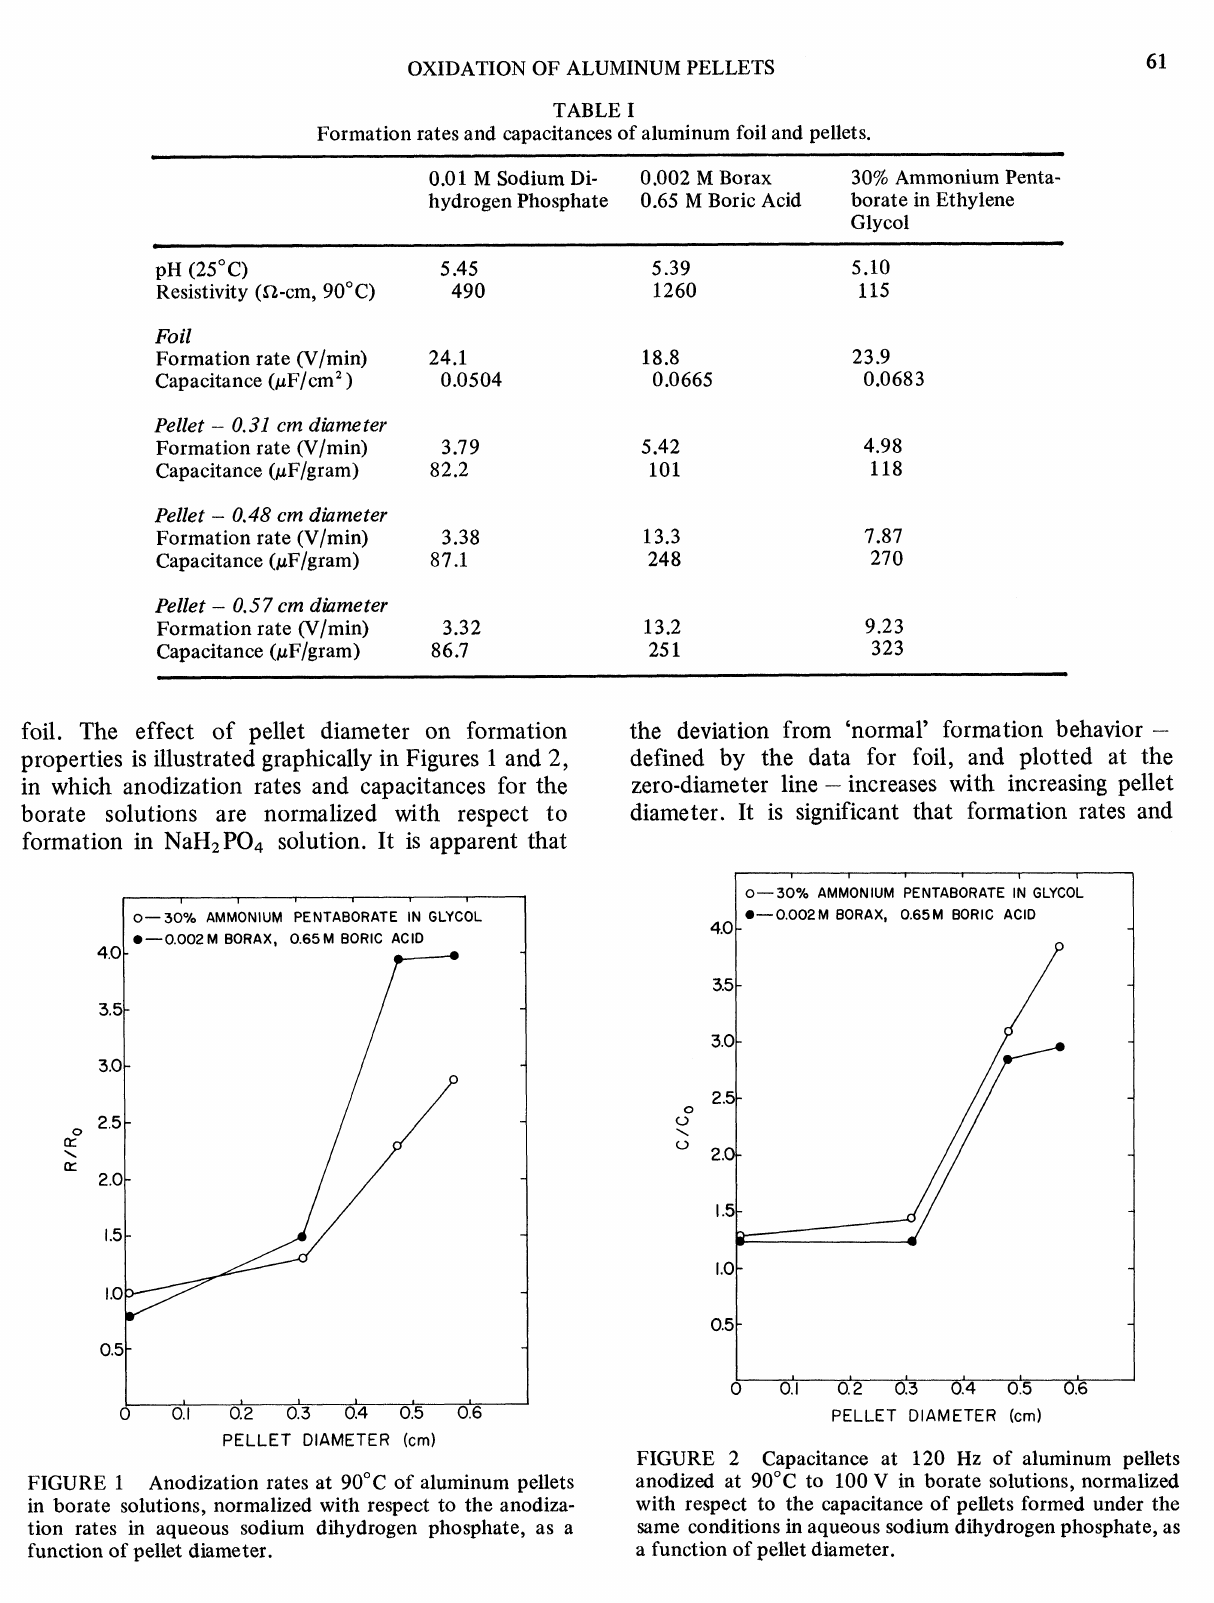
Anodization rates at 90C of aluminum pellets in borate solutions, normalized with respect to the anodiza- tion rates in aqueous sodium dihydrogen phosphate, as a function of pellet diameter.